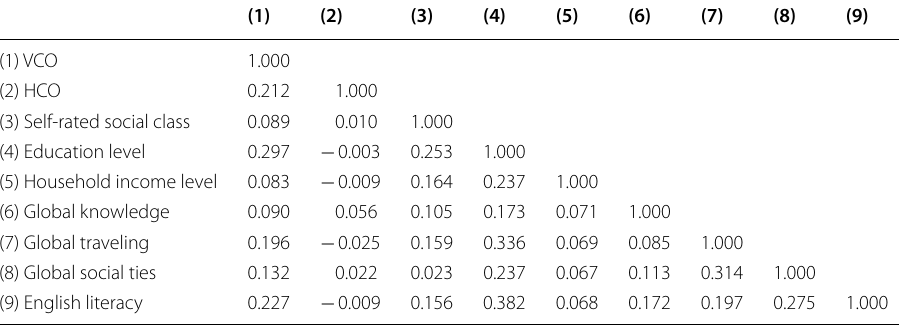
Table 2 Correlation matrix of key